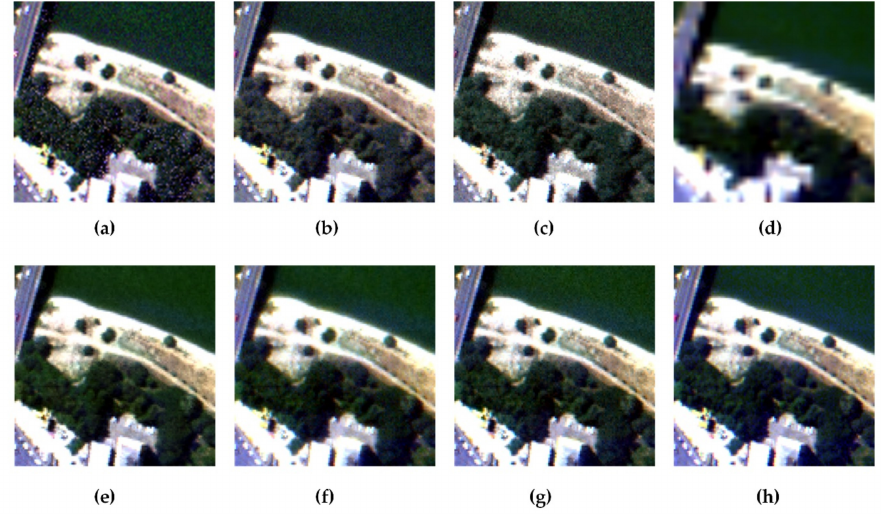
Figure 6. Local enlargements of fusion result of Pavia City center. ( a ) CNMF; ( b ) JNMF; ( c ) DPLM; ( d ) LR HS image; ( e ) TCNNF; ( f ) DiCNN; ( g ) CpCNN; ( h ) Reference high-resolution, hyperspectral (HR HS)